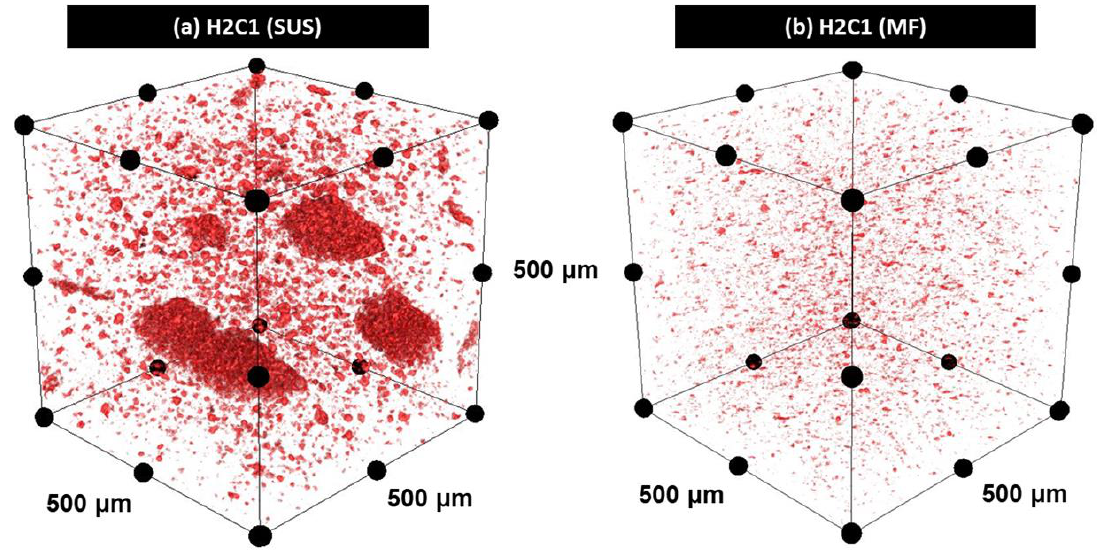
Figure 3. Three-dimensional X-ray micro-CT analysis on H2C1 composites made by ( a ) SUS and ( b ) MF.